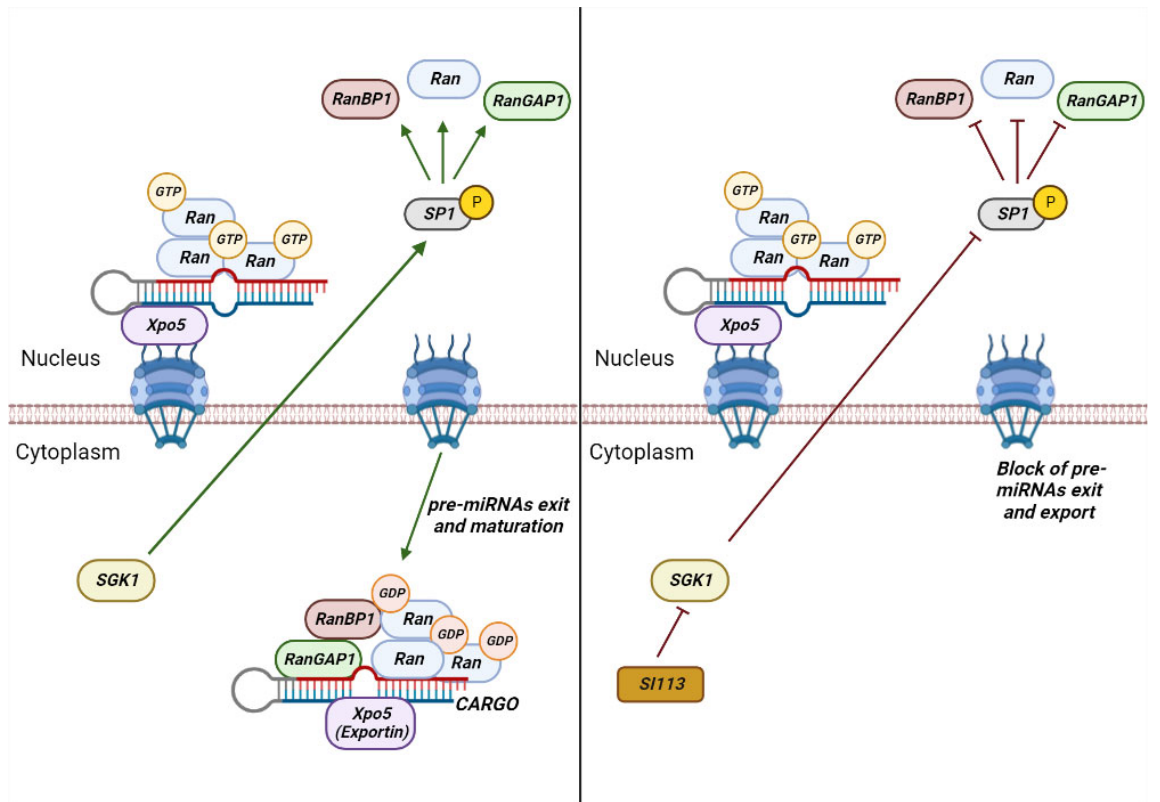
Figure 3. SGK1 regulates the RAN/RANGAP1/RANBP1 axis, influencing pre-miRNAs nuclear export and maturation. The figure depicts the SGK1-dependent pre-miRNAs nuclear export regulation, by modulating the RAN complex in SP1-dependent manner. Conversely, the SGK1 activity inhibition affects pre-miRNAs’ export and maturation in the cell cytoplasm (see also Section